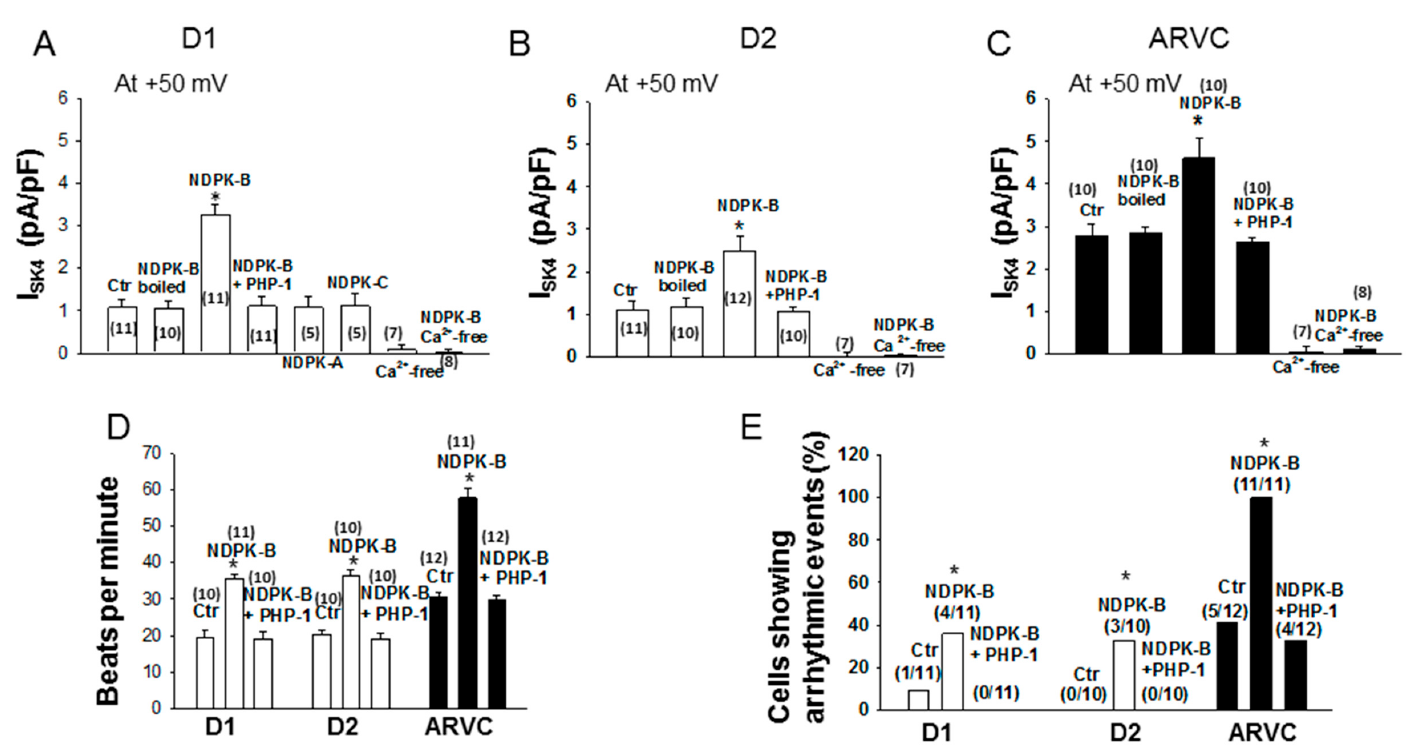
Figure 4. Recombinant NDPK-B enhanced Sk4 channel currents, and beating frequency and occurrence rate of arrhythmic events. Recombinant NDPK (NDPK-B, NDPK-A, NDPK-C, each 30 ng / mL) either alone or with PHP-1 (100 ng / mL) was applied into healthy donor (D1, D2) or ARVC cells though the patch pipette. I SK4 or spontaneous action potentials (sAPs) were measured 3 min after whole-configuration was established. The intracellular Ca 2 + concentration was 500 nM. ( A – C ) Mean values of I SK4 in donor and ARVC-cells showing that NDPK-B but not the inactivated (boiled) kinase or NDPK-A or NDPK-C enhanced I SK4 and PHP-1 abolished the NDPK-B e ff ects. ( D ) Beating frequencies in donor and ARVC cells showing higher frequencies with NDPK-B. ( E ) Occurrence rate of arrhythmic events (early or delayed afterdepolarizations or triggered beats or bigeminy-like or torsade de pointes-like events) in donor and ARVC cells influenced by NDPK-B. * p < 0.05 versus control (Ctr). The numbers given in parentheses represent cell numbers.